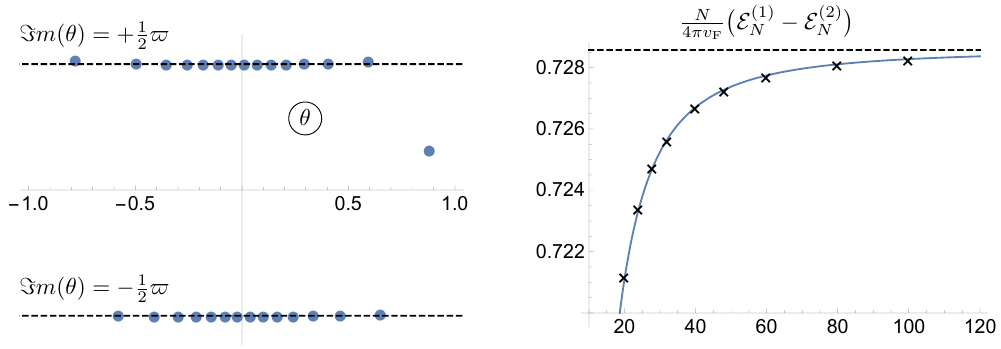
Figure 4 . The first excited states of the Hamiltonian H with N/ 2 even and S z = 0 form a doublet. The Bethe roots for the states in the doublet are related to each other via complex conjugation. Depicted in the left panel of the figure is the typical pattern of Bethe roots in the complex θ (cid:0) ¯ (cid:1) (cid:0) (cid:1) plane for the Bethe state, which flows to ¯ e 1 , +1 P (vac) ⊗ e 1 , +1 P (vac) . The right panel compares R R the numerical data for the difference E (1) − E (2) with the prediction (12.61). The crosses were N N computed via the Bethe ansatz, while the solid blue line is the fit 0 . 72858 − 2 . 9919 /N 2 . The dashed black line represents the r.h.s. of eq. (12.61). Note that, in the case at hand, I ( e ) − ¯ I ( e ) is zero, 1 1 while the eigenvalue of I ( o ) on the Ramond primary states follows from eq. (9.19) and the last 1 column of table 1. The parameters were set to be β 2 = 0 . 43 , k = 0 . 1 and $ = 1 . 8 , so that P vac)